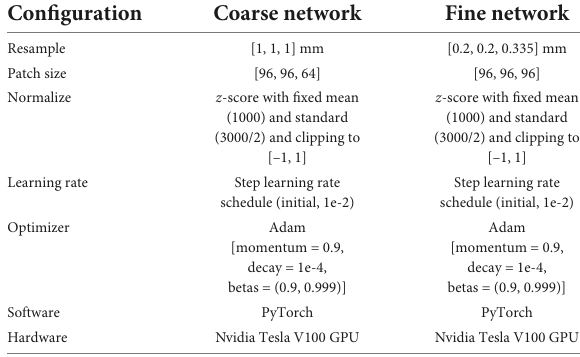
TABLE 1 The detailed configuration for coarse-to-fine segmentation